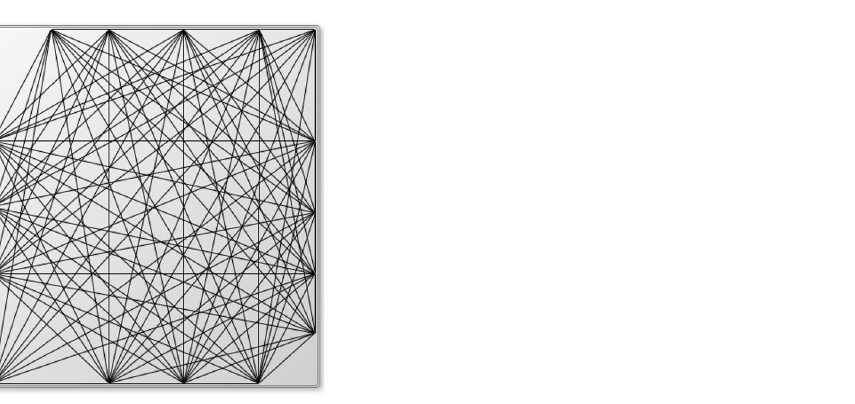
Figure 7. Distribution of used BLE channels relative to the 2.4 GHz band (green).